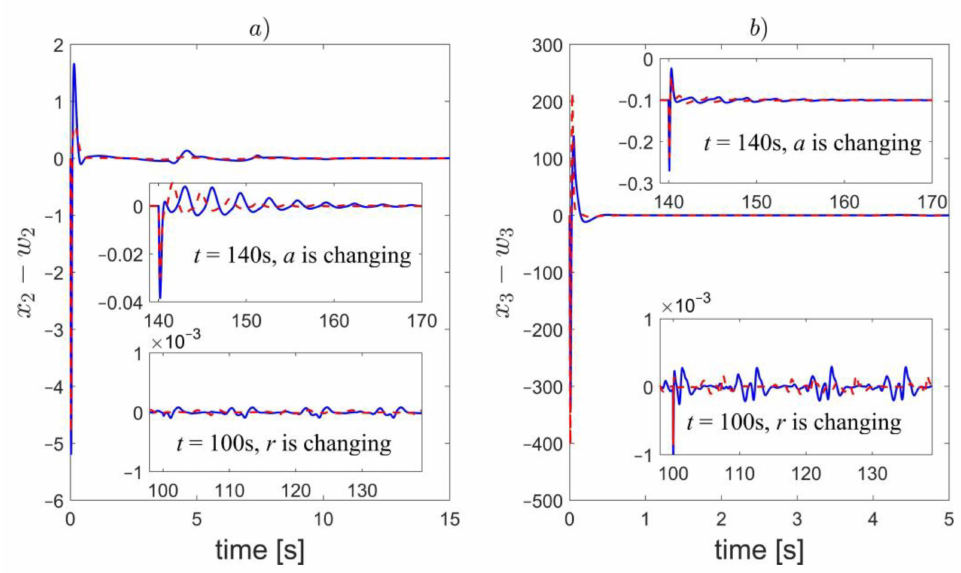
Figure 10. ( a ) Synchronization error x 2 − w 2 ; ( b ) synchronization error x 3 − w 3 ; design parameters: K 1 = K 2 = K 3 = 10, solid line; design parameters: K 1 = K 2 = K 3 = 15, dashed